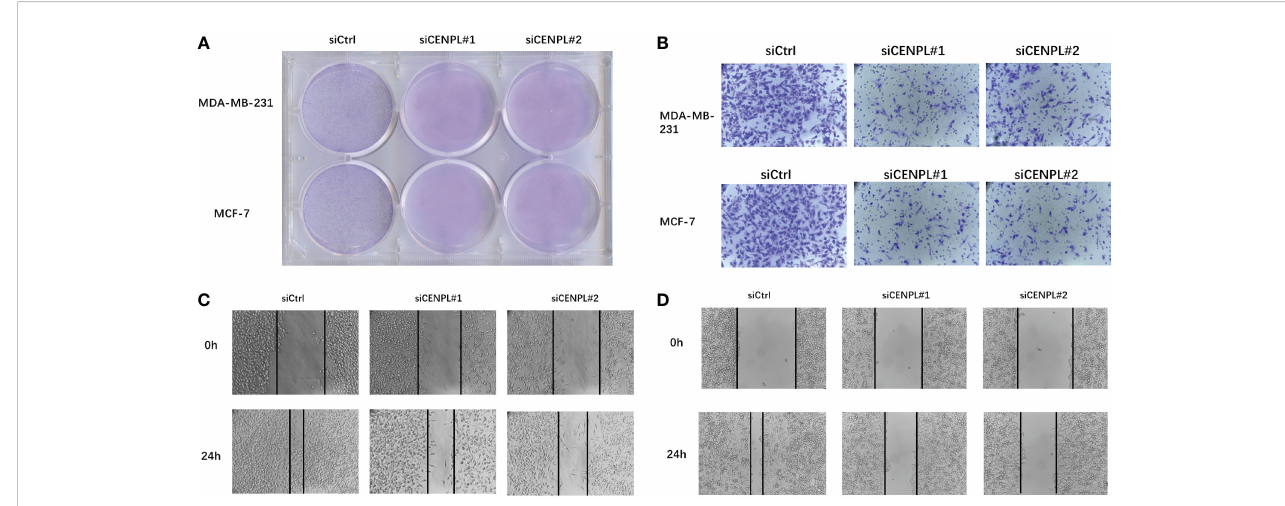
FIGURE 9 Clone formation experiment, Transwell experiment and scratch experiment. (A) Clone formation of control group and two siRNA knockout groups in MDA-MB-231 and MCF7 cell lines. (B) Transwell images of control group and two siRNA knockout groups in MDA-MB-231 and MCF7 cell lines. (C – D) Scratch test images of control group and two siRNA knockout groups in MDA-MB-231 and MCF7 cell lines.